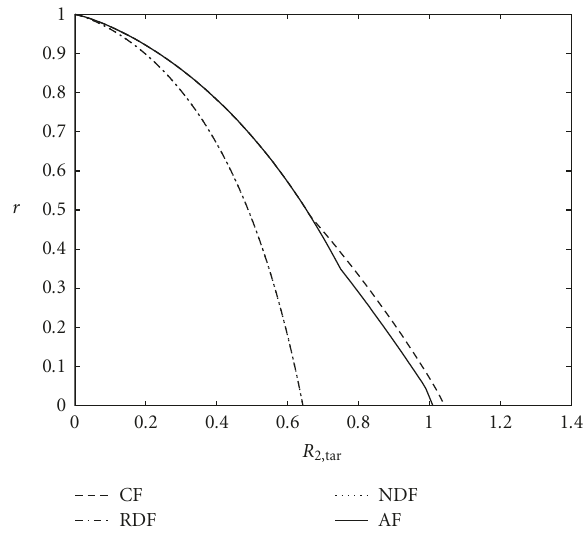
Figure 5: Resource allocation from the jointly optimal algorithm in Scenario